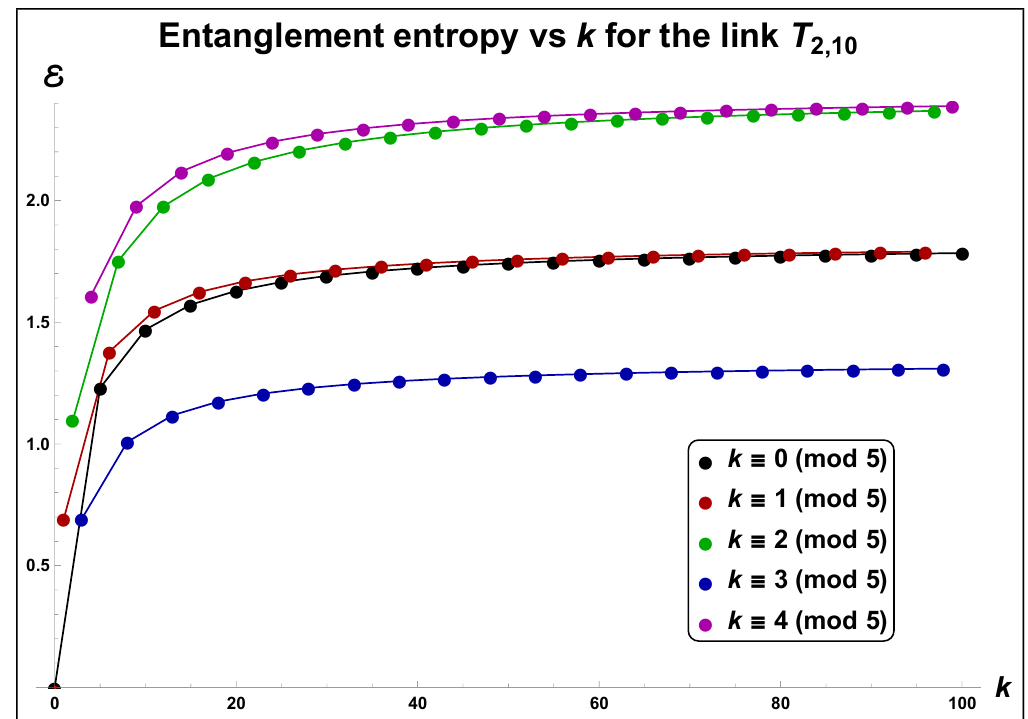
Figure 9. The variation of the SU (2) k entanglement entropy with k computed for the state | T 2 , 10 i . The entropies follow different patterns for ‘ ∈ { 0 , 1 , 2 , 3 , 4 } . In the large k limit, patterns for ‘ = 0 , 1 and ‘ = 2 , 4 merge which is clear from